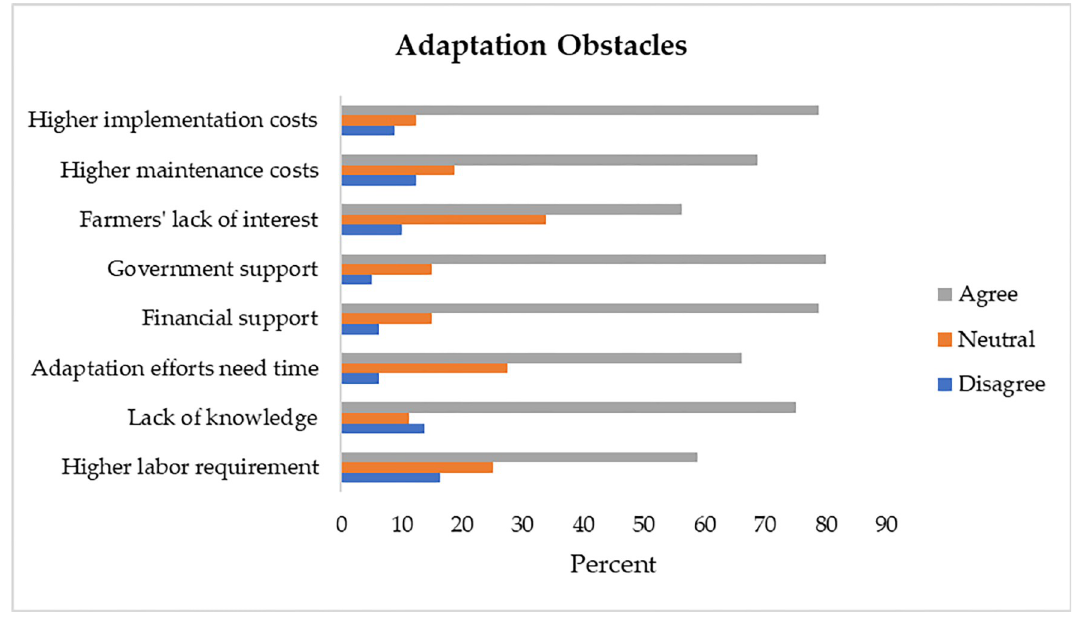
Fig 3. Farmers views about adaptation obstacles.